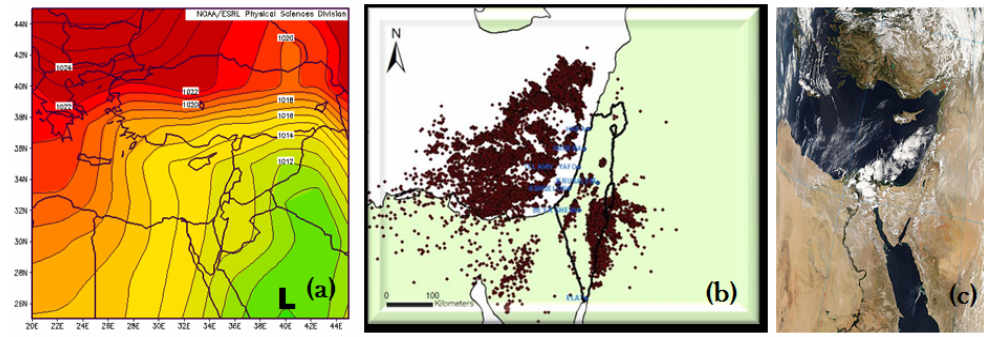
Fig. 9. As in Fig. 7 but for the “hybrid” type, 24 October 2008. The MODIS satellite image was taken at 11:05